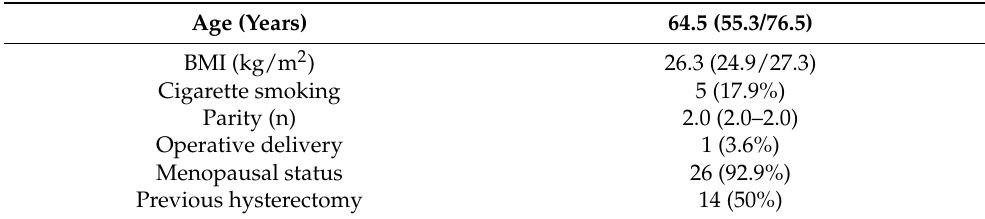
Table 1. Population characteristics. Data as absolute (relative) frequencies for categorical variables and median (interquartile range) for continuous ones.